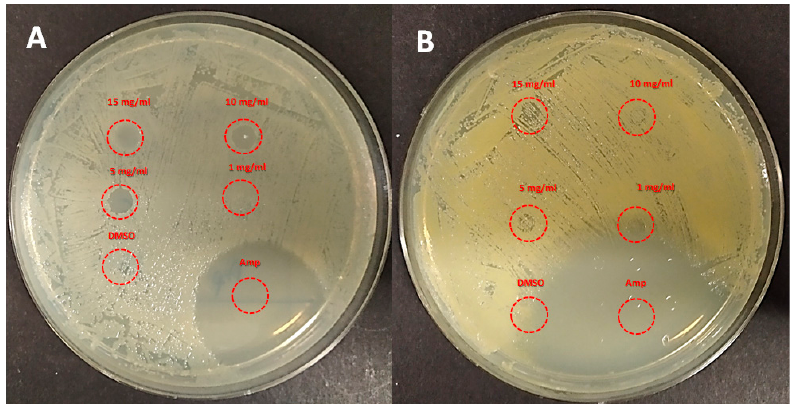
Figure 4. Antimicrobial effect of CoPol1 at decreasing concentrations (15, 10, 5, and 1 mg/mL) on E. coli K12-MG1655 ( A ) and S. aureus ATCC 6538P ( B ), respectively. DMSO and ampicillin (x mg/mL) are included as controls.